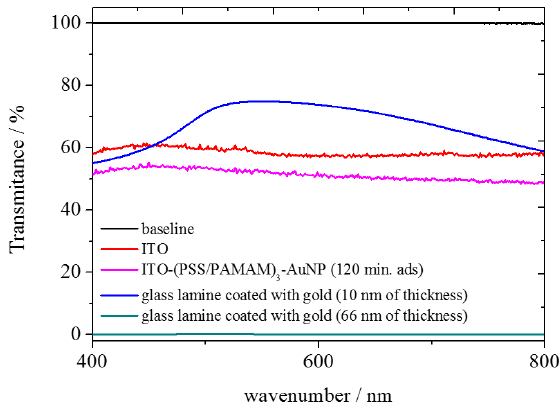
Figure 6 - electronic spectroscopy at visible range of baseline in air (black), ITO (red), ITO-PAmAm-(PSS/PAmAm) AuNPs (pink), glass lamine Au-coated with 10 nm of thickness (blue) and glass lamine Au-coated with 66 nm of thickness